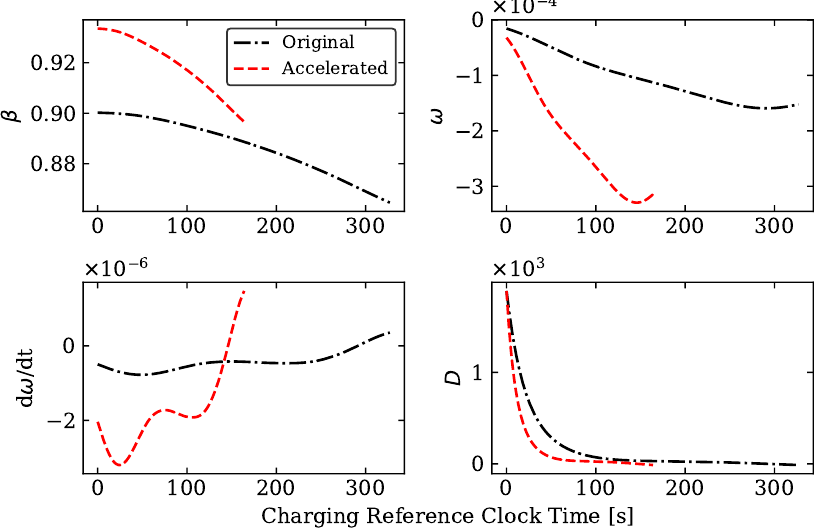
Figure 15. Comparison of discharging mode at the inlet location, phase